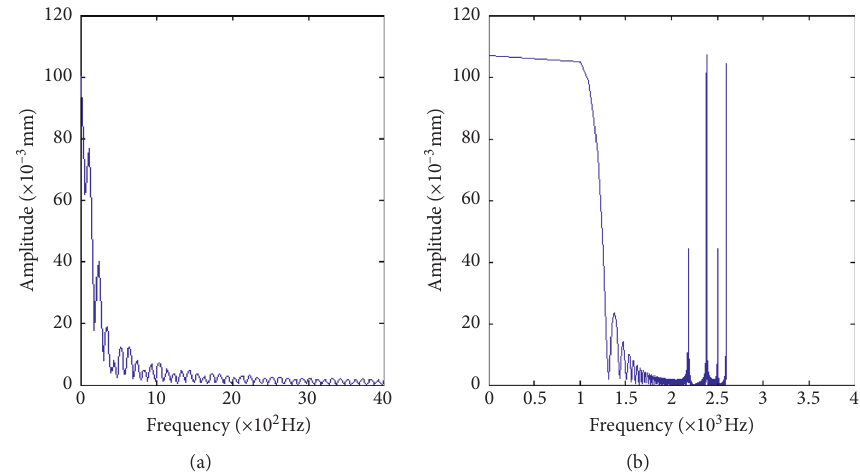
Figure 8: Frequency-domain of the dynamic cutting forces at the depth of cut ( a � 0 . 01 mm), cutting speed ( V � 400mm/min. (a) Tangential component. (b) Normal component. velocity V w